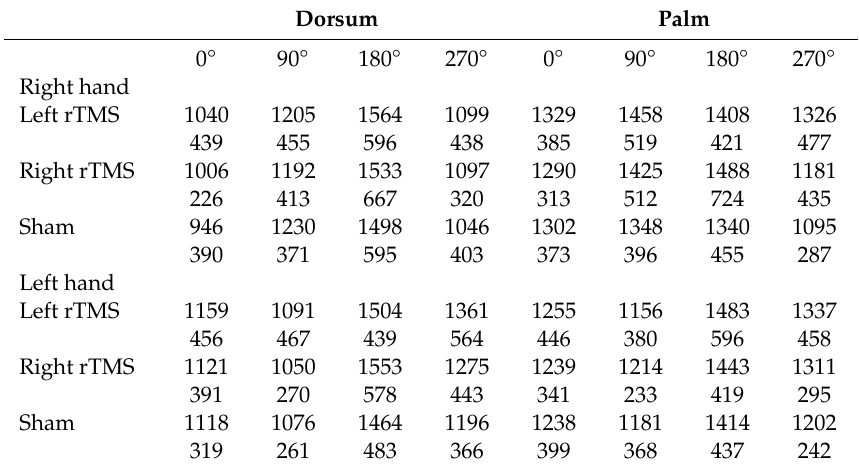
Table 2. Meanreactiontimes(RTs)(msec)andSD,separatelyforhandview(dorsumandpalm), orientation (0 ◦ , 90 ◦ , 180 ◦ , and 270 ◦ ), laterality (left and right), and stimulation condition (left, right and sham). Dorsum